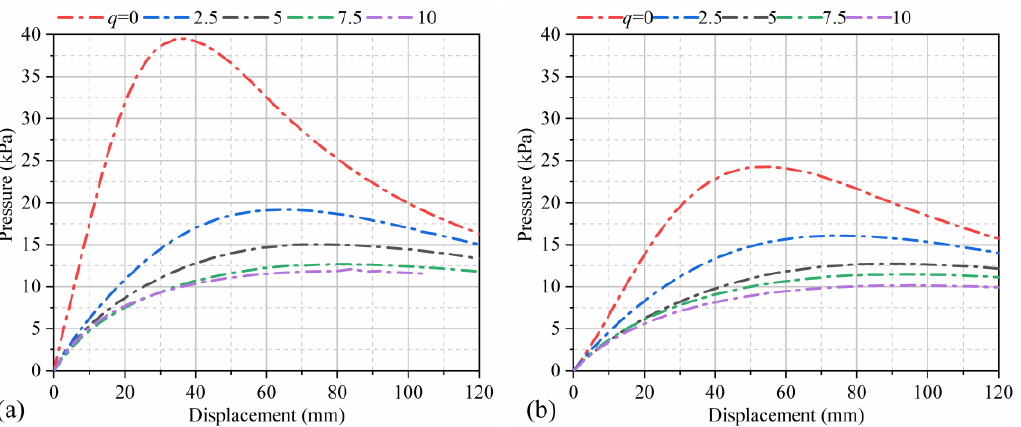
Figure 9. The pressure – displacement curves of FIPP liner with different q under ( a ) a / R = 0.99; ( b ) a / R = 0.98.